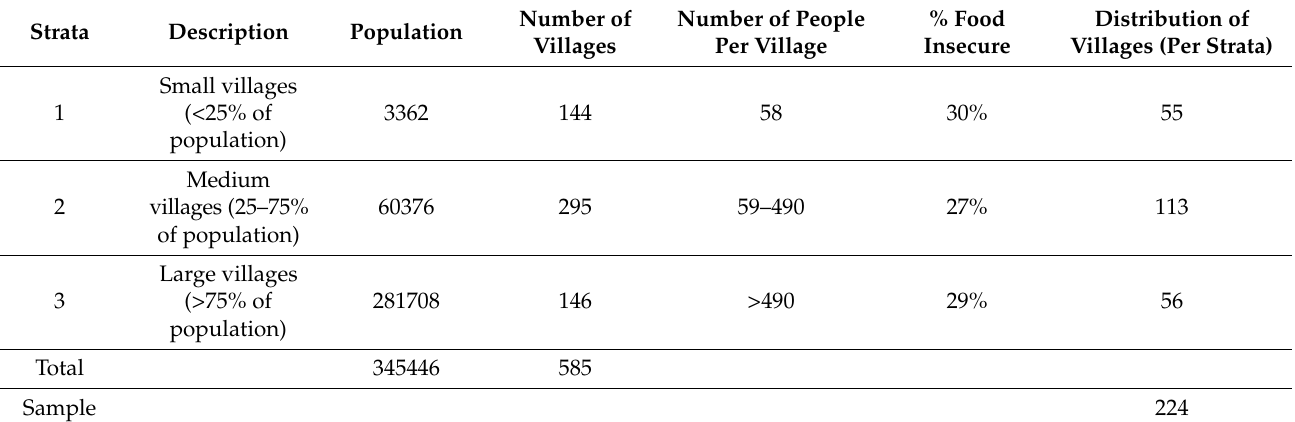
Table 2. Sampling